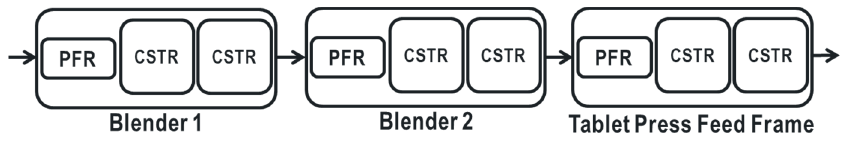
Figure 4. Schematic of Blending Unit and Theoretical Reactor Design.